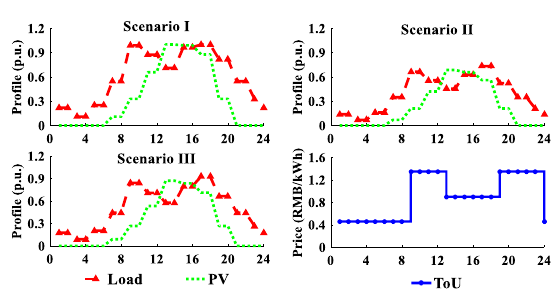
Fig. 4 Curves of load, PV generation and ToU electricity